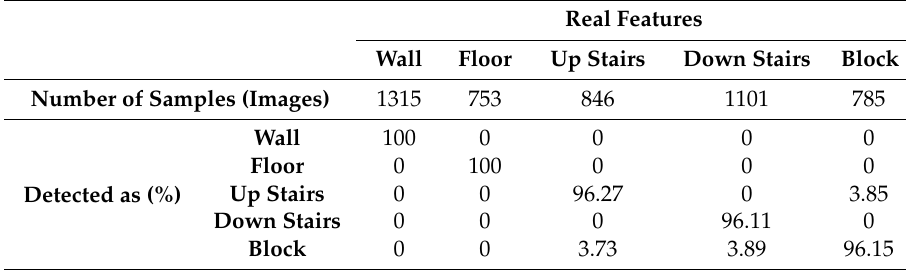
Table 3. Obstacle classification accuracy (%) within the effective working range (1.8 m).